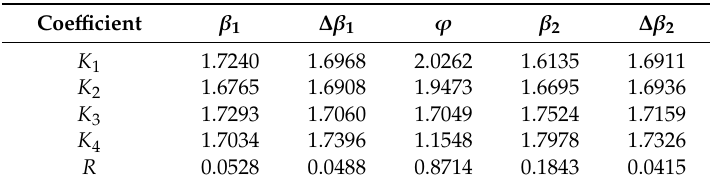
Table 6. Range analysis of fan e ffi ciency.